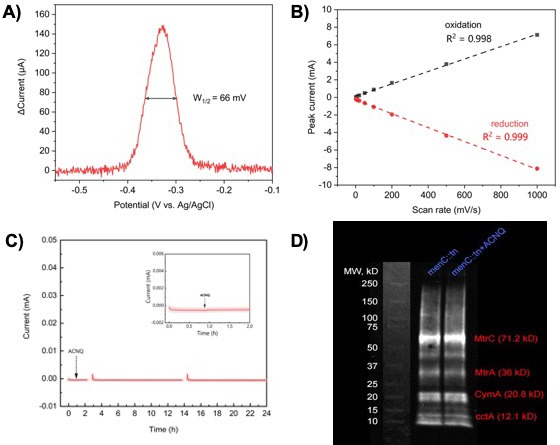
ACNQ acts as an electron shuttle and does not affect cytochrome c protein expression.(A) Differential pulse voltammetry (DPV) of ACNQ in M9 media. (B) The relationship between ACNQ redox peak current and CV scan rate from non-turnover MR-1 biofilm. (C) Chronoamperometry (−0.1 VAg/AgCl) of clean carbon felt electrode in M9 media, 1 μM ACNQ was added after the oxidation current is stable. (D) Enhanced chemiluminescence (ECL) analysis of menC::Tn10 and menC::Tn10 with ACNQ, key cytochrome c proteins involved in extracellular electron transfer are noted in red.